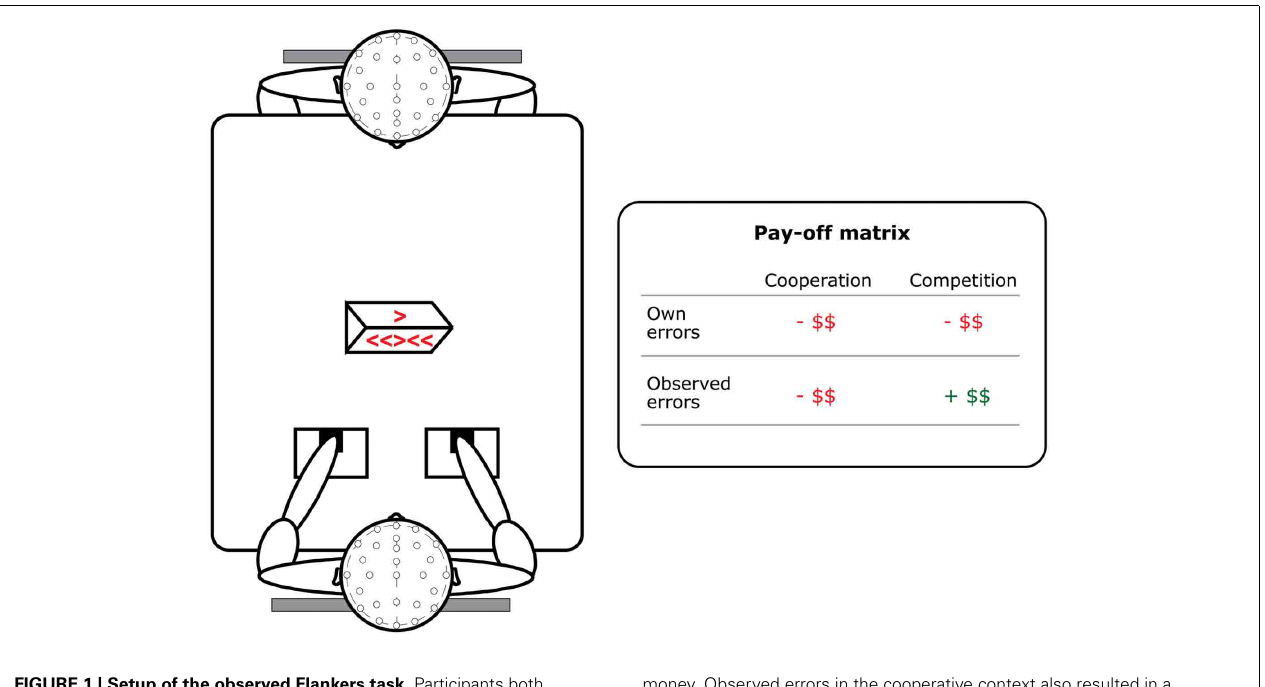
FIGURE 1 | Setup of the observed Flankers task. Participants both performed and observed 600 trials in a cooperative and in a competitive context. Own errors were always associated with a loss of